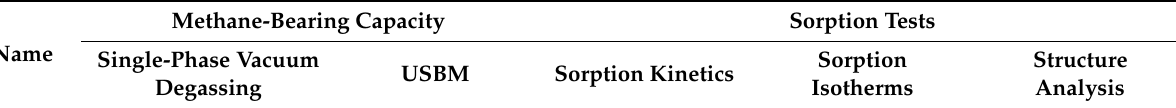
Table 2. Coal samples taken from the Upper Silesian Coal Basin intended for laboratory